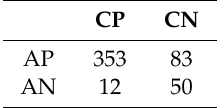
Table 7. Detection rate of dynamic hazardous objects in the diagonal direction